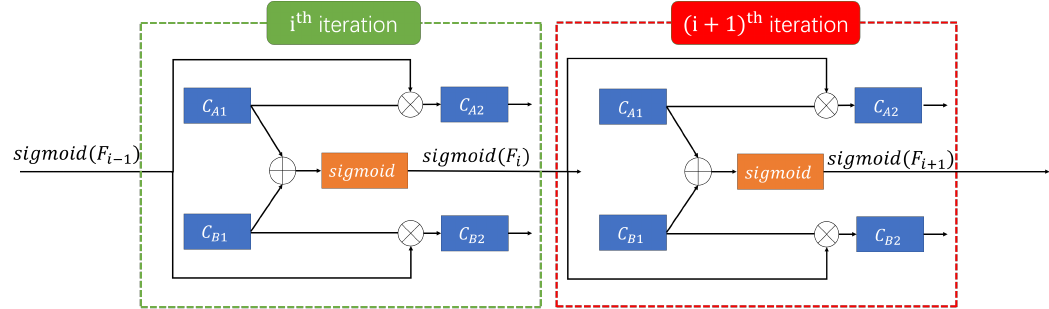
Figure 4. The mechanism of multi-task learning method with feature-level fusion and